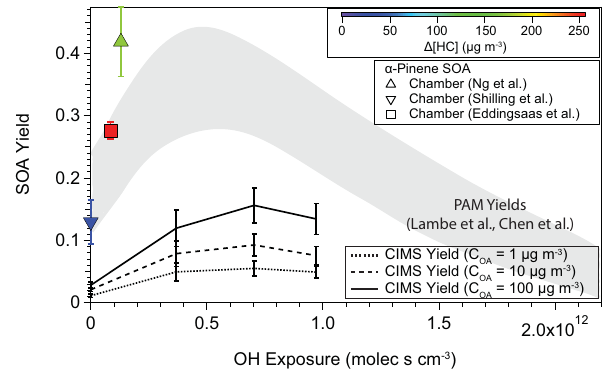
Figure 7. SOA yields estimated by the acetate-CIMS in this study and previously reported SOA yields from scanning mobility par- ticle sizer (SMPS) measurements for α -pinene oxidation systems. The dotted black lines depict CIMS yields calculated for C OA = 1, 10, and 100µgm − 3 . The gray shaded region represents the do- main of yields determined from PAM experiments across OH ex- posure where the amount of α -pinene reacted ranged from 227 to 556µgm − 3 . Zero OH exposure corresponds to ozonolysis. Square and triangle points indicate yields determined from chamber experi- ments; their colors are indicative of the amount of α -pinene reacted. Error bars represent 1 σ uncertainty from spectral variation, precur- sor concentration, sensitivity, and vapor pressure